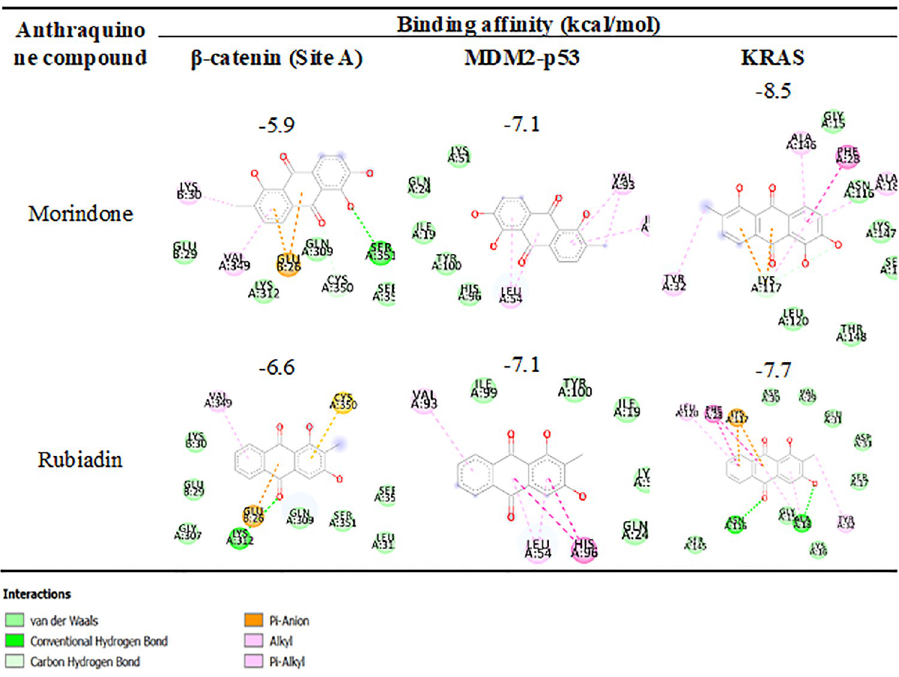
Fig 3. Two-dimensional diagram of residues binding interaction of morindone and rubiadin with β -catenin (Site A), MDM2-p53, and KRAS. Each residue is colored by the type of interaction; van der Waals (light green), hydrogen bond (green), and polar (magenta and orange).